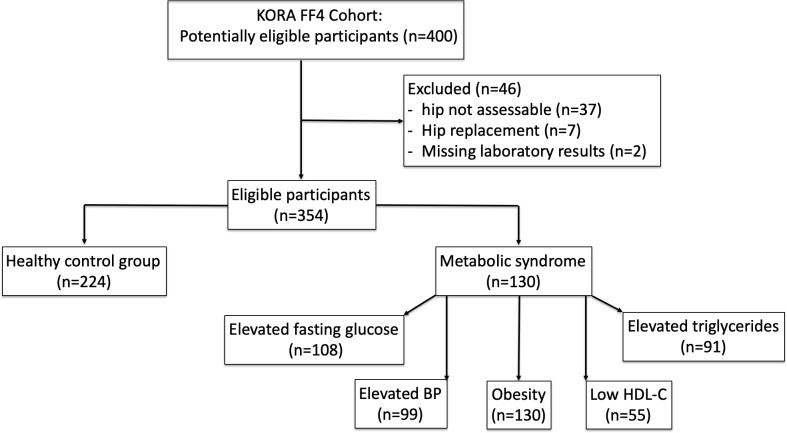
Inclusion flow chart.